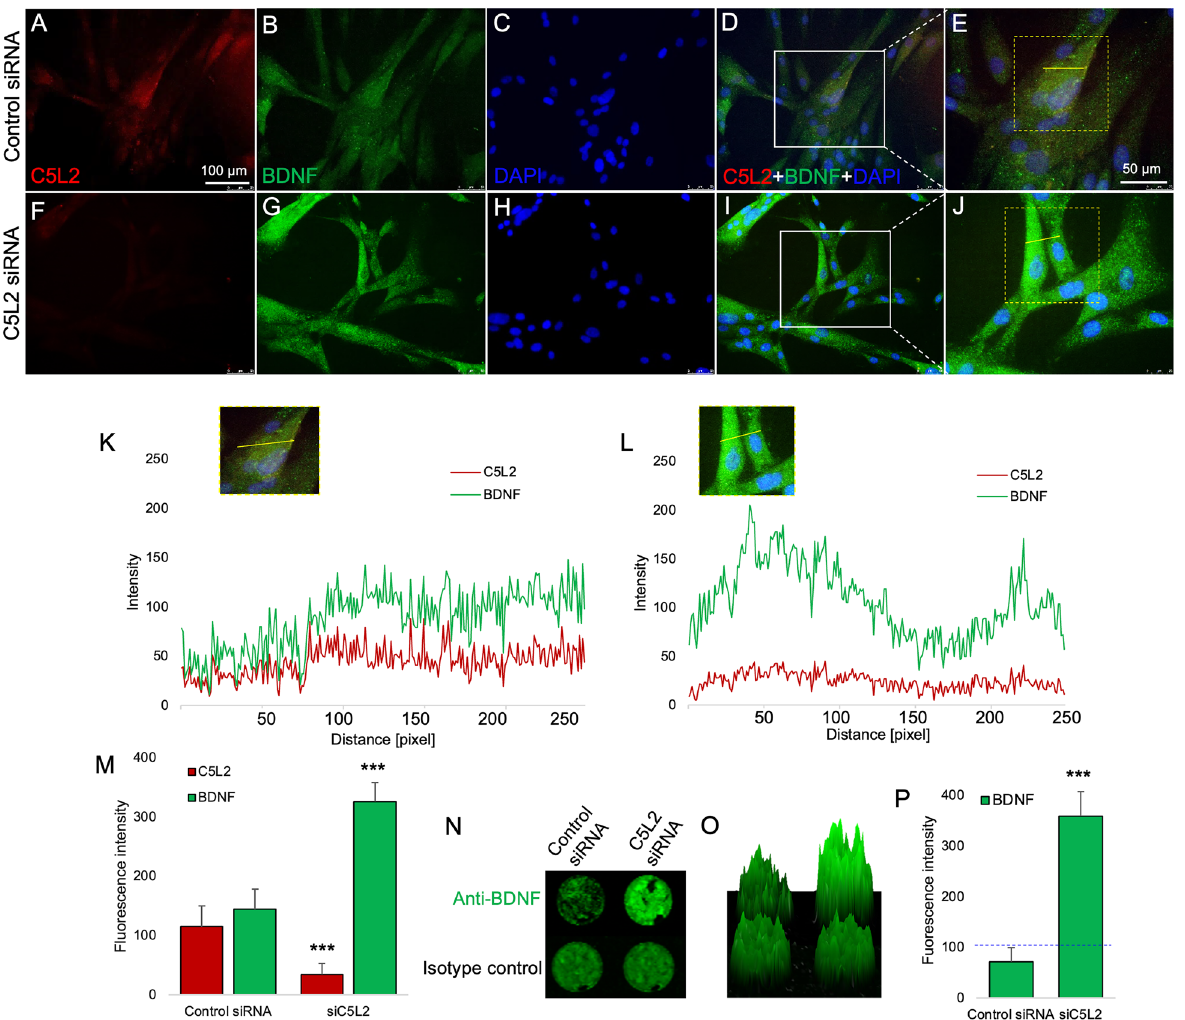
Figure 2. Effect of C5L2 silencing on BDNF expression in DPSCs. ( A - J ) Cells were cultured and transfected with control siRNA or C5L2 siRNA and immunofluorescence double staining was used to analyze the expression of C5L2 and BDNF among DPSCs. DAPI was used to counterstain nuclei. Remarkably, C5L2 silencing enhanced BDNF expression in DPSCs ( F - J ) compared with control ( A-E ). ( K-L ) Enlarged Fig. E and J were analyzed showing co-localization of C5L2 and BDNF in control siRNA-treated cells ( K ) and enhanced BDNF expression with reduced C5L2 expression ( L ) indicating that C5L2 silencing enhances BDNF expression in DPSCs. (M) Bar graph shows increased fluorescence intensity of BDNF among siC5L2 treated cells ( F-J ) compared with control ( A-E ). ( N-P ) Similarly, the in-cell western assay showed increased immunofluorescence of BDNF in C5L2 silenced well compared to control. ( O ) 2.5D model depicting similar results displaying a high peak of BDNF among C5L2 silenced cells. ( P ) Bar graph shows significant increment in BDNF expression in C5L2 silenced DPSCs (*** p < 0.001 vs